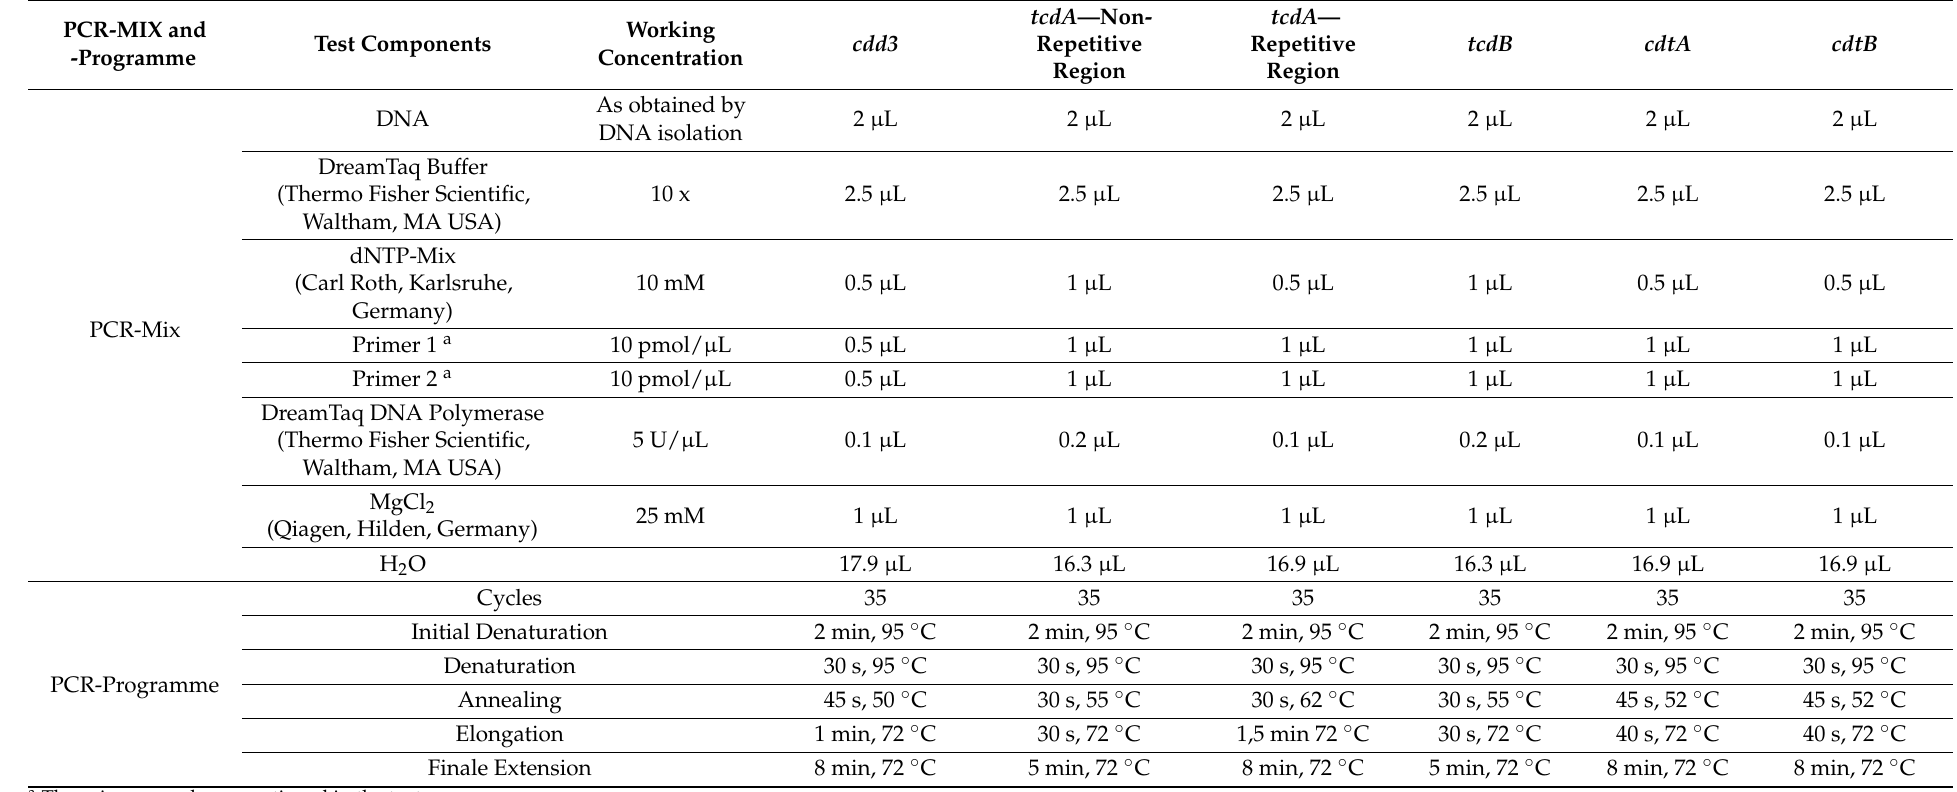
Table 6. PCR-protocols for C. difficile species confirmation and toxin gene